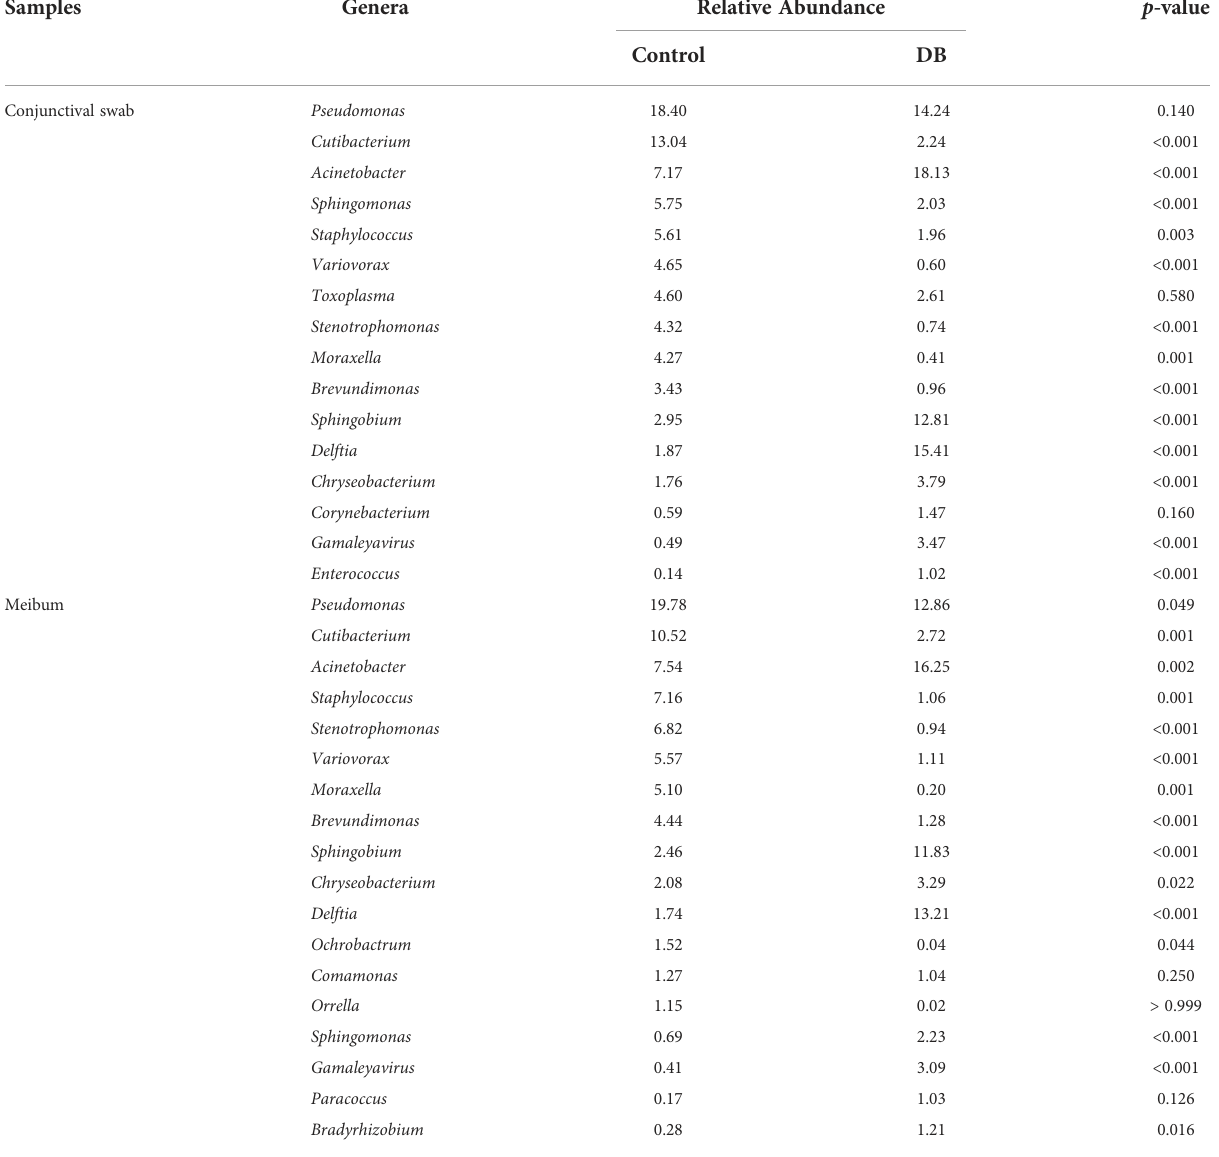
TABLE 3 Genera in the conjunctival swab or meibum samples of controls and Demodex blepharitis groups (Relative Abundance>1%).